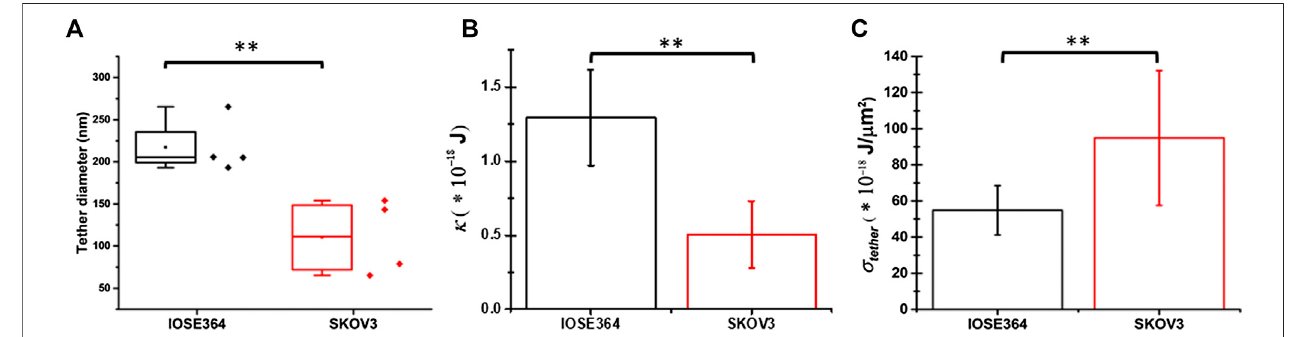
FIGURE6| Box-and-whiskerplotsfor (A) tetherdiameter,andmeanvaluesof (B) membranebendingmodulus( κ ),and (C) tethermembranetension( σ tether ).Error bars in panels (B) and (C) indicate standard deviations from the mean. **Indicates a statistically signi fi cant difference with p (cid:1) 0.010 (A) , (B) p (cid:1) 0.007 (B) , and p (cid:1) 0.006 (C)